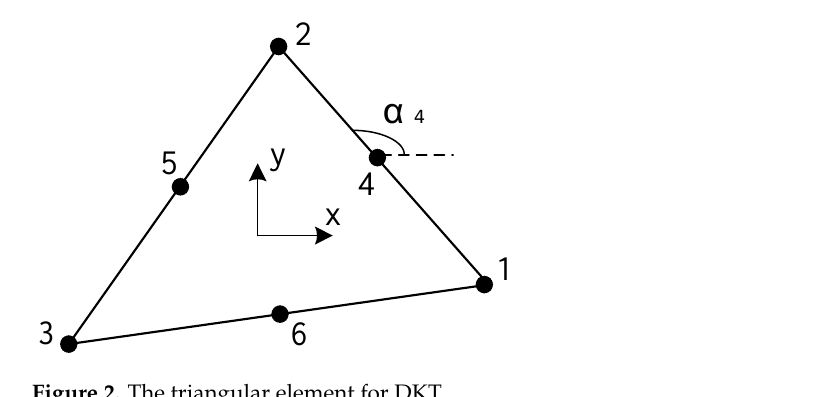
Figure 2. The triangular element for DKT.